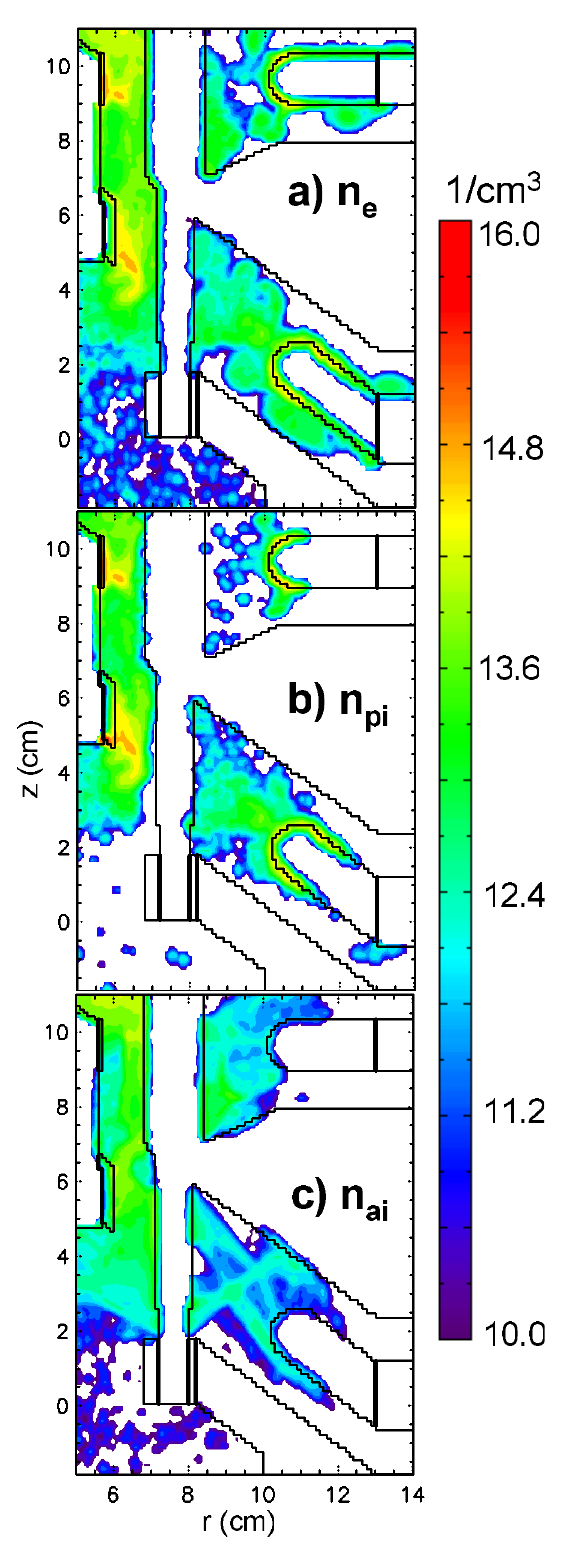
FIG. 6. (Color) Logarithmic-scale density contours in the (cid:1) (cid:4) 0 plane at 120 ns for the simulation (with D (cid:4) 0 : 0075 ml = ns , case 4F); (a) electron density, (b) cathode-emitted plasma ions, and (c) the anode-emitted